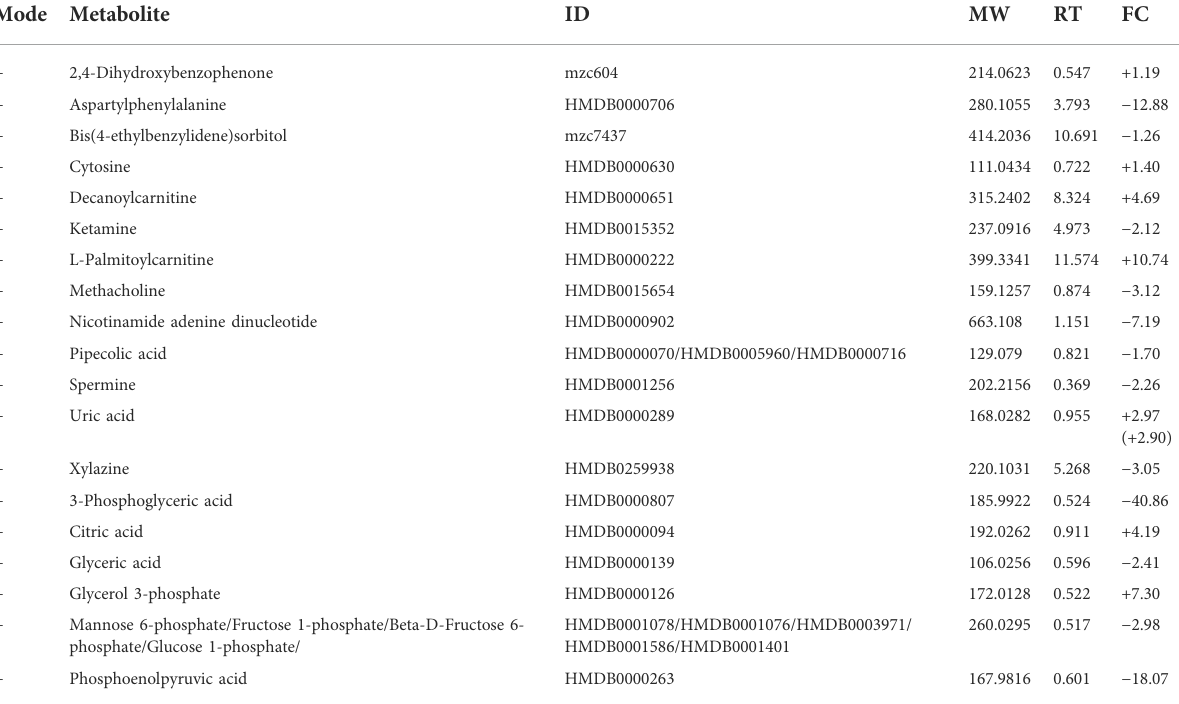
TABLE 1 List of signi fi cant metabolites in AC against YC. Mode